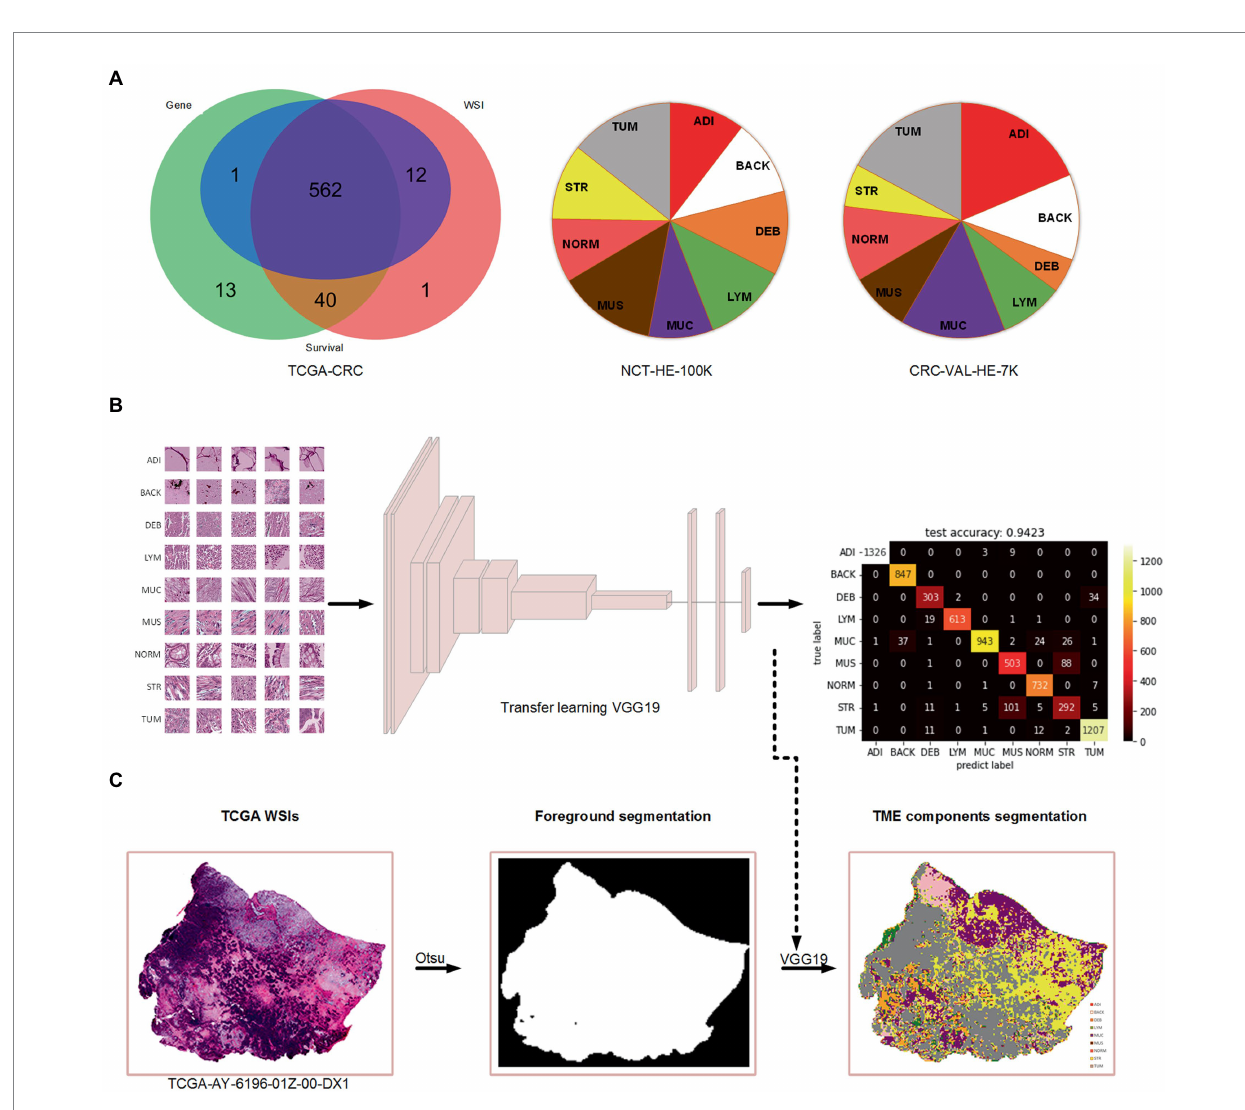
FIGURE 1 The data used in the present study and the process of TME components recognition. (A) Venn diagram of the collected data from TCGA-CRC and the percentage of nine tissue types in two cohorts of Kather et al.’s study. (B) Training a VGG19-based tissue recognition model by transfer learning strategy. (C) An example of foreground segmentation and TME components